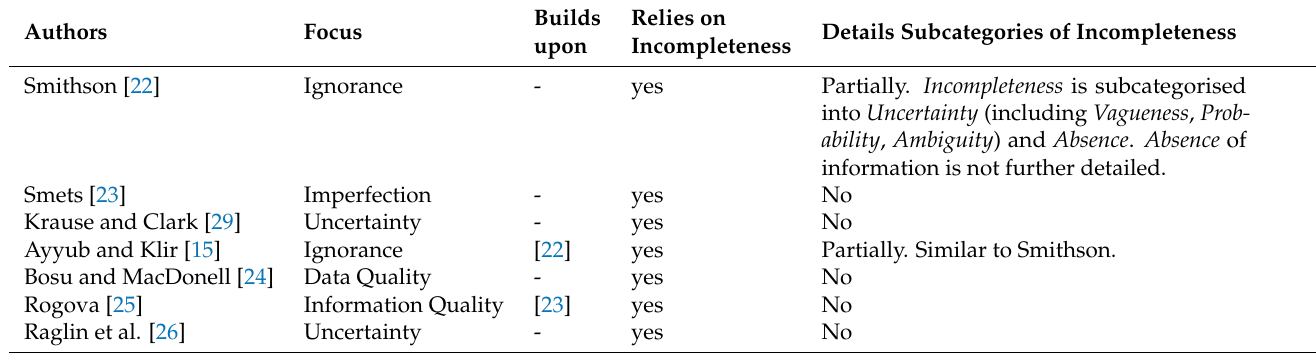
Table 1. Taxonomies of uncertainty, imperfection, ignorance, and quality which address the topic of data or information incompleteness (in the sense of missing data or information, i.e., scarcity). Incompleteness is recognised as the main concept of imperfection throughout the referenced works. However, a categorisation of the various kinds of missing data or information is not carried